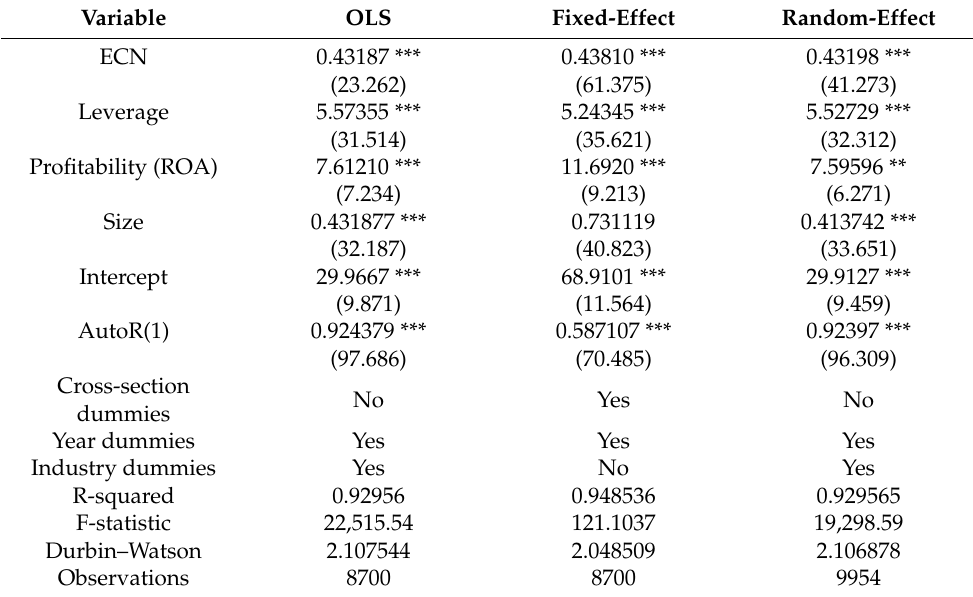
Table 5. Determinants ofenvironment, social and governance(ESG) sustainability